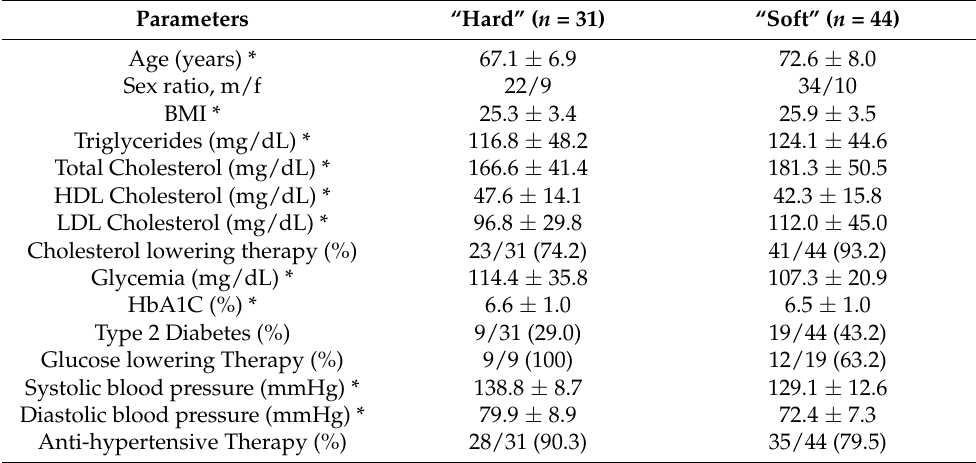
Table 1. Main clinical parameters of patients sorted according to the plaque typology (hyperechoic or “hard” plaques and hypoechoic or “soft” plaques). Parameters “Hard” ( n = 31) “Soft” ( n = 44) Age (years) * 67.1 ±